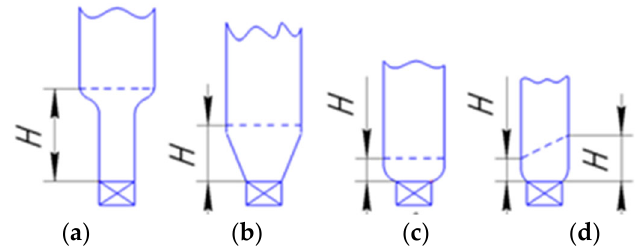
Figure 9. Forms of tubular film, depending on the height of the crystallization line: ( a ) high crystallization sleeve, ( b ) normal crystallization sleeve, ( c ) low crystallization sleeve, ( d ) asymmetric crystallization sleeve.